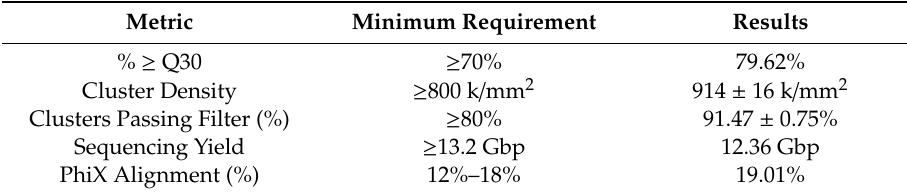
Table A1. Sequence quality metrics per sequencing